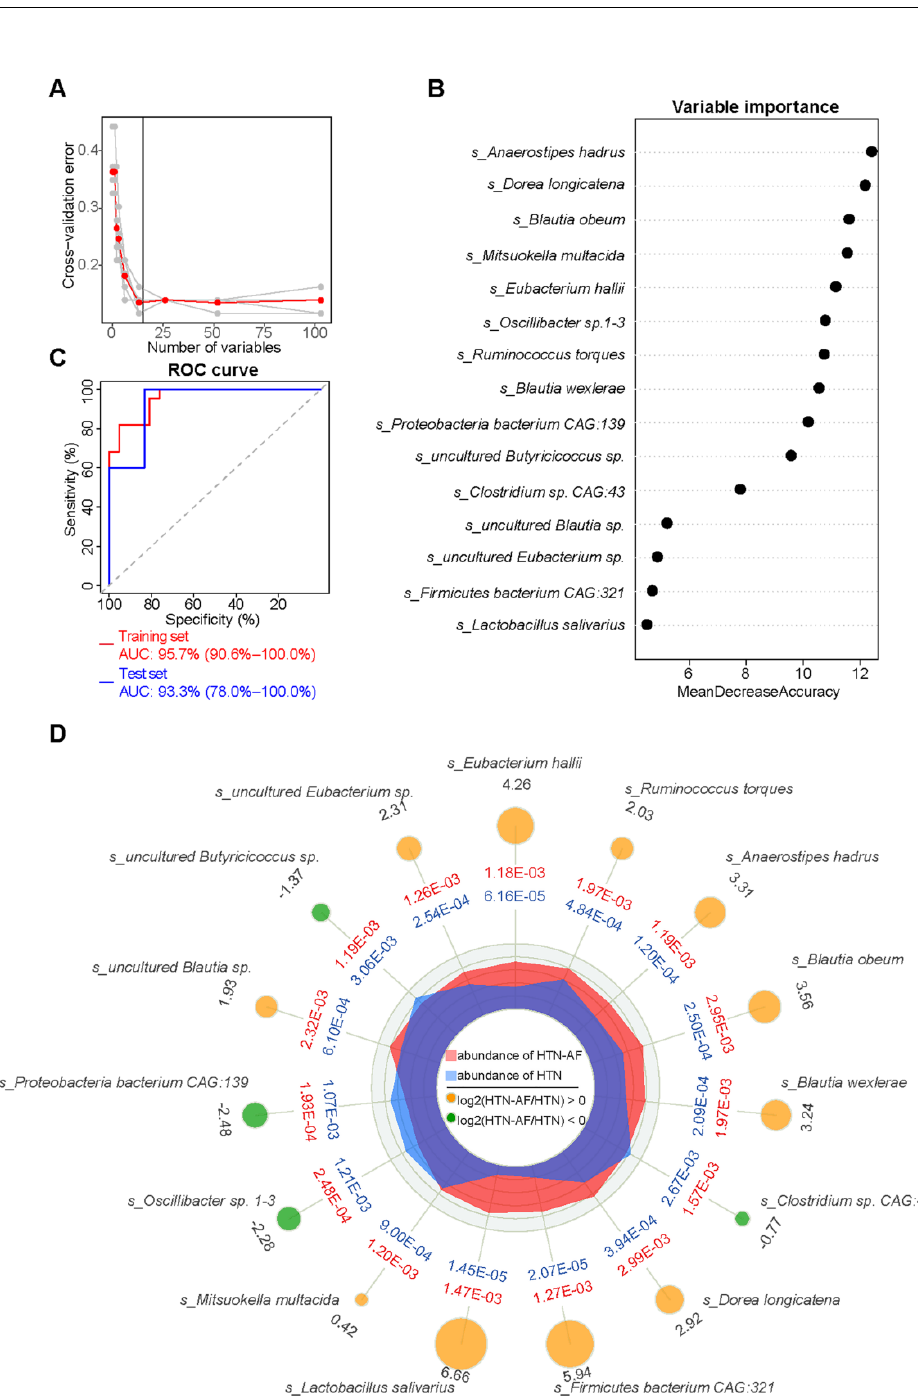
Figure 7. A species-based random forest model for predicting AF occurrence in HTN patients. ( A ) The random forest disease classifier, trained on the relative abundance of the species in the HTN and HTN-AF as variables, describing the distribution of five trials of 10-fold cross-validation error and the number of species in the optimal set with the lowest cross-validation error. ( B ) The variable importance of selected species. ( C ) Receiver-operating characteristic curve (ROC) analysis on the training (AUC = 95.7%, 95% CI: 90.6 – 100.00%) and test sets (AUC = 93.3%, 95% CI: 78.0 – 100.00%).